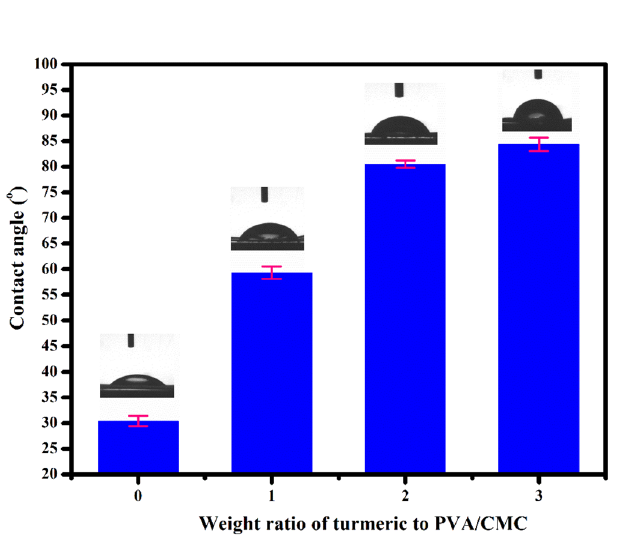
Figure 7. Water contact angle of PVA/CMC/TUR